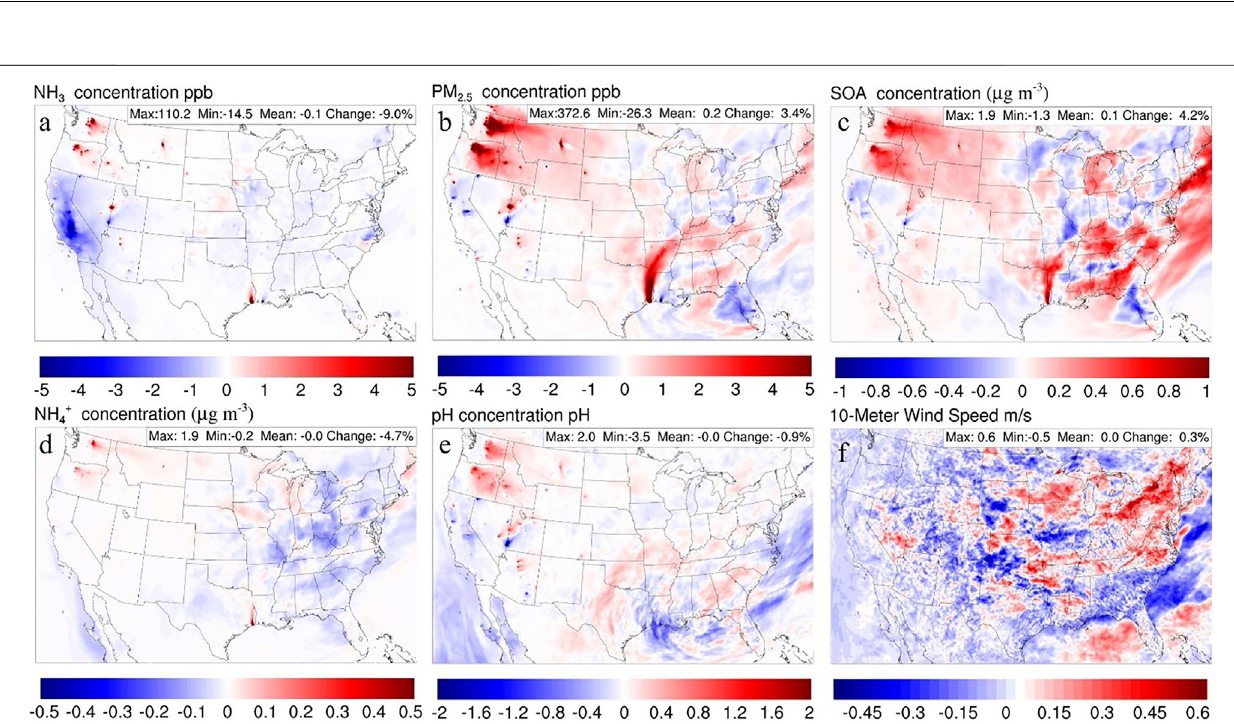
Frontiers in Environmental Science |